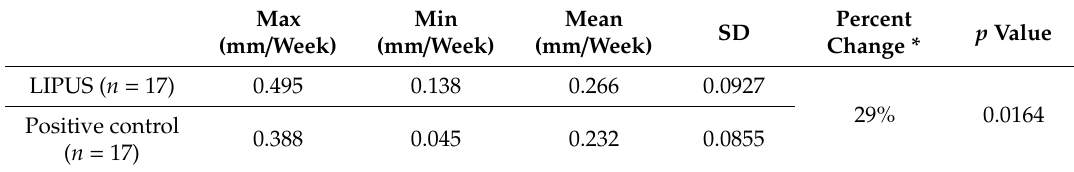
Figure 4. Comparison of the weekly rate of tooth movement in the active group. Table 2. Comparison of the weekly rate of tooth movement between the LIPUS and the positive control sides in the split-mouth group.